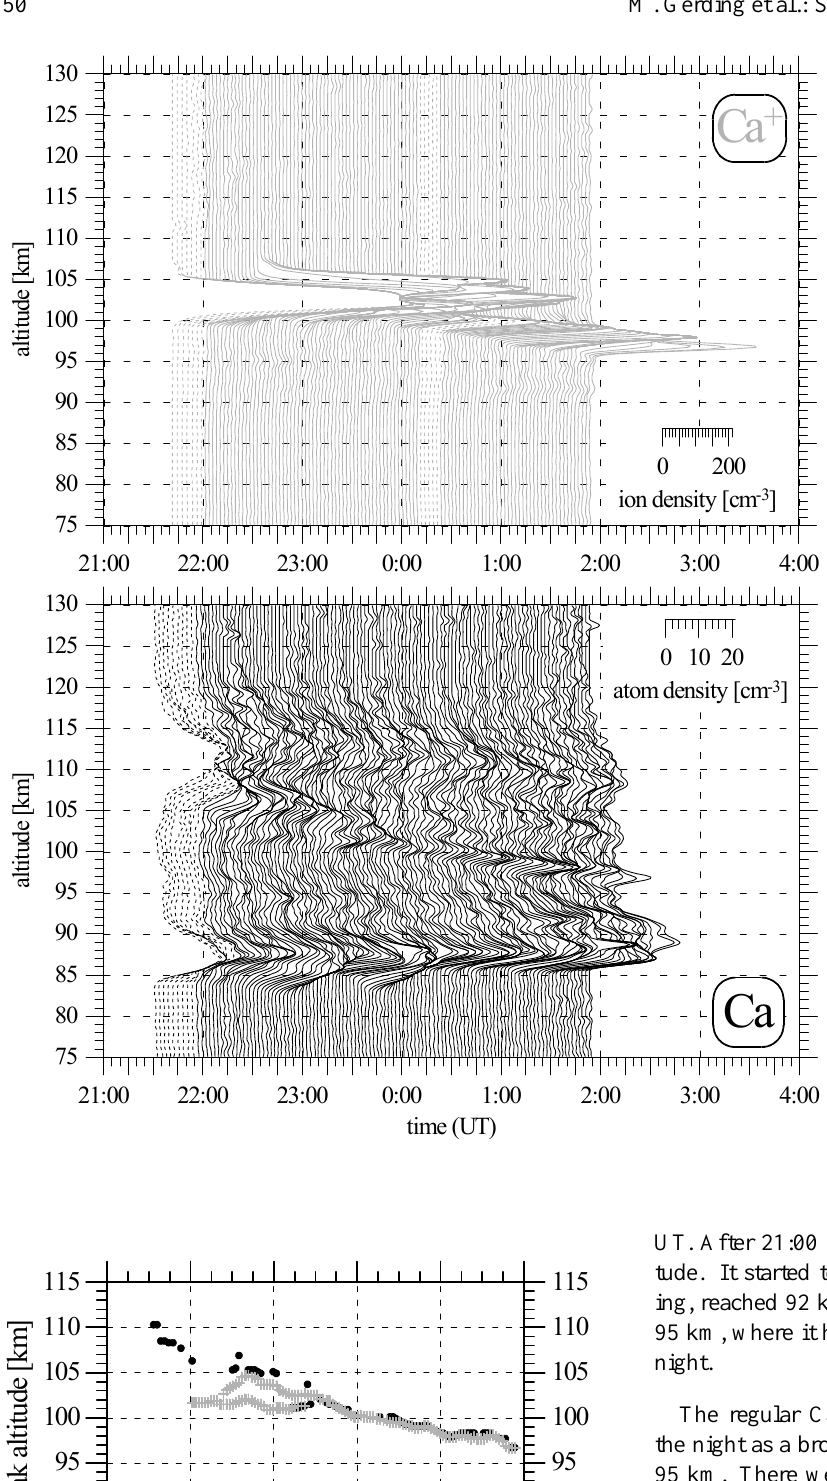
Fig. 4. Altitude variation of the Ca s (dots) and Ca + s (crosses) during the night August 1/2,